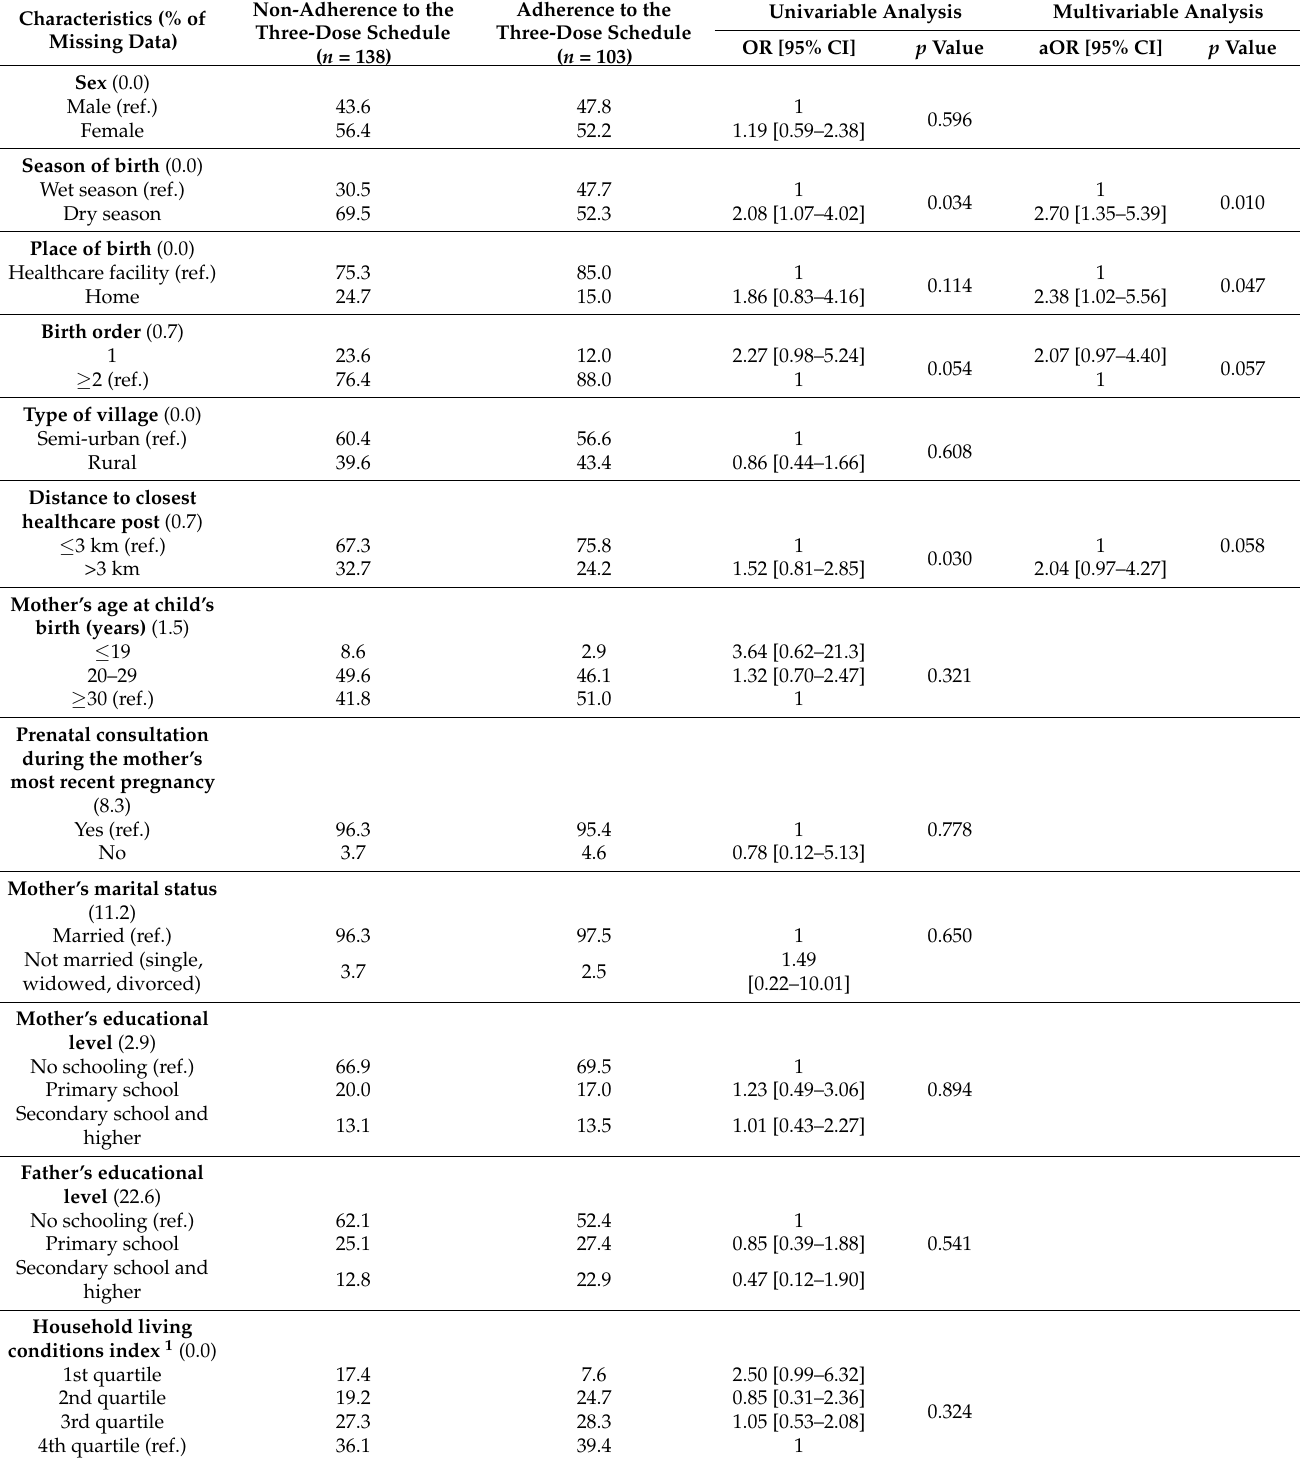
Table 3. Factors associated with non-adherence to the WHO-recommended three-dose hepatitis B virus (HBV) vaccine schedule in children born on or after 1 January 2016, living in the mostly rural area of Niakhar ( n = 241 children participating in the ANRS 12356 AmBASS survey with available vaccination data, logistic regression models using weighted and calibrated